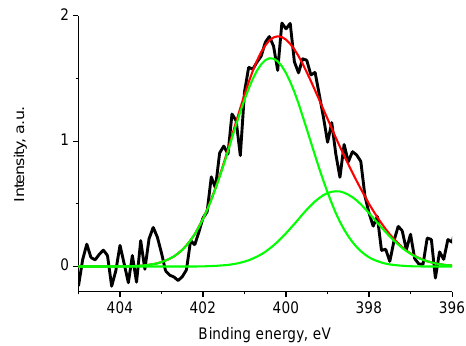
Figure 28. The N 1s photoelectron spectrum of sample 2 (initial spectra – black, basic curves – green, resulting curve – red).